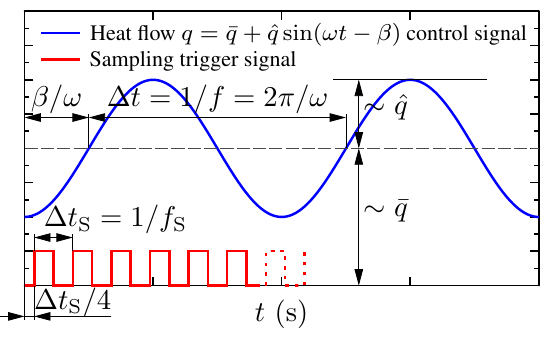
Fig. 6. Illustration of the time dependencies of the signal con- trolling the generated heat flux and the sampling signal for mea- suring the